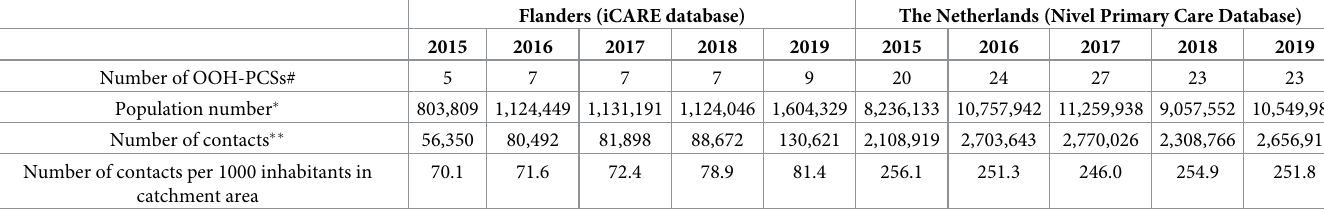
Table 1. Description of the OOH-databases in Flanders and the Netherlands. Flanders (iCARE database) The Netherlands (Nivel Primary Care